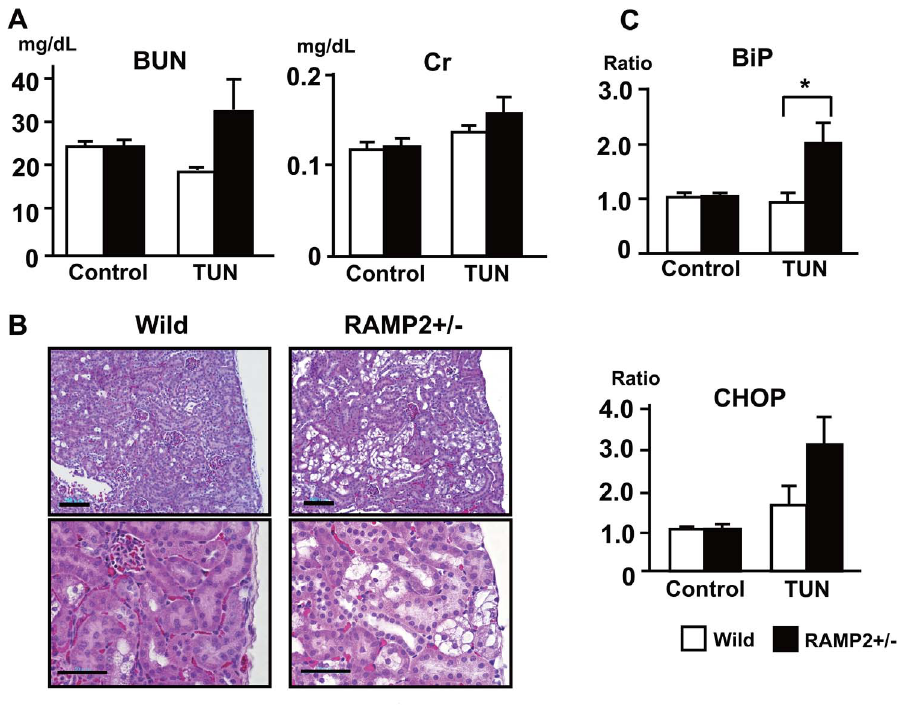
Figure 7. Tunicamycin (TUN) induces tubular injury and upregulation of ER stress-related factors in RAMP2 + / 2 kidneys. (A) Serum BUN and creatinine (Cr) in wild-type and RAMP2 + / 2 4 days after administration of vehicle (Control) or TUN (0.5 mg/kg). (B) H&E staining of the renal cortex in TUN-treated wild-type and RAMP2 + / 2 kidneys. Scale bars in upper panels=100 m m, lower panels=50 m m. Sections from RAMP2 + / 2 kidneys showed severe tubular injury with cell vacuolation. (C) Quantitative real-time PCR analysis of BiP and CHOP gene expression. TUN-treated RAMP2 + / 2 kidneys showed upregulation of ER stress-related factors. Data from the wild-type control group were assigned a value of 1. n=5 in each group. Bars are means 6 SEM. *p ,